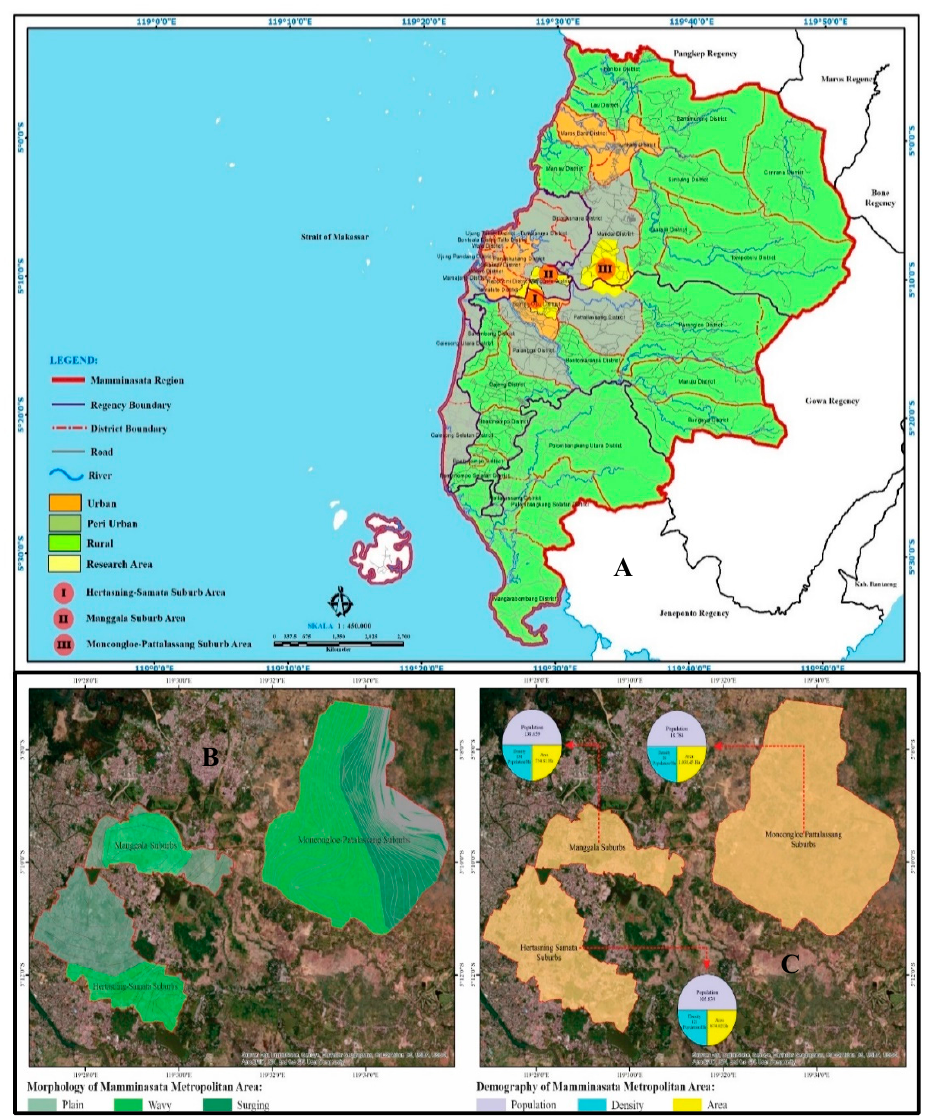
Figure 2. A, B, C, Mamminasata Metropolitan Urban Study Area. Source: author elaboration; Figure 2. ( A – C ) Mamminasata Metropolitan Urban Study Area. Source: author elaboration; Folder © Folder (c) 2019 Google. 2019